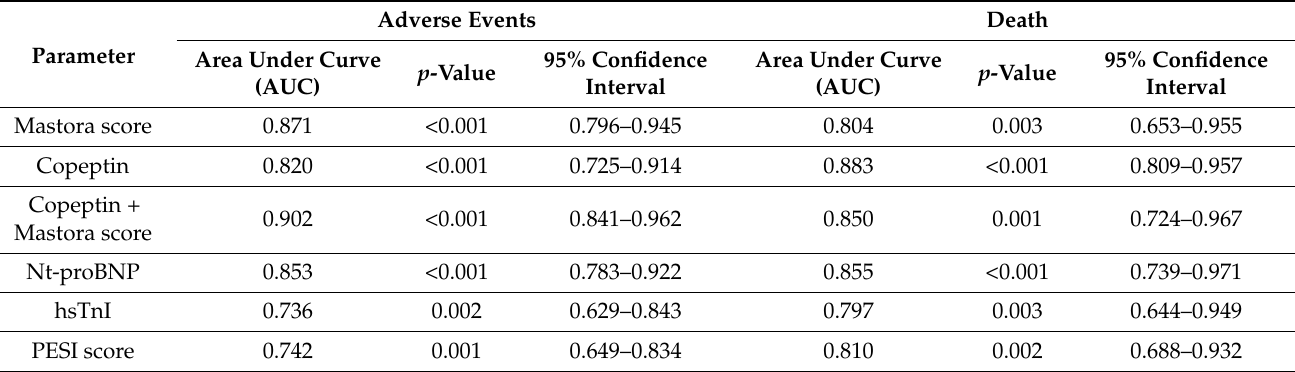
Table 5. AUC derived from ROC analysis for prediction of adverse events and death.